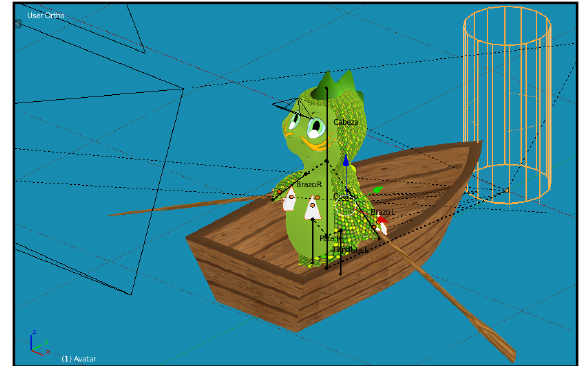
Fig. 10: Phiby’s model in the boat showing the avatar (cylinder grid) to check collisions, the camaras for 1 st and 3 rd person views (black pyramidal grids) and the “rope” tool (white objects) used to transmit the rowing movement to the rudders.